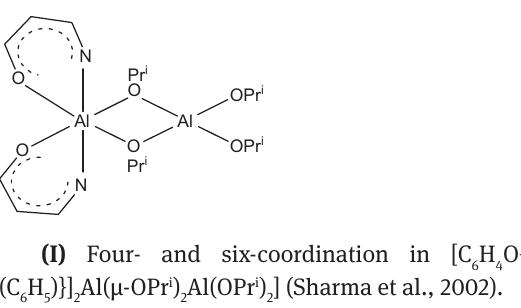
) Al( μ -OPr i ) Al { OC(R) = CH C(R ′ ) = NC 3 2 2 H } 6 5 2